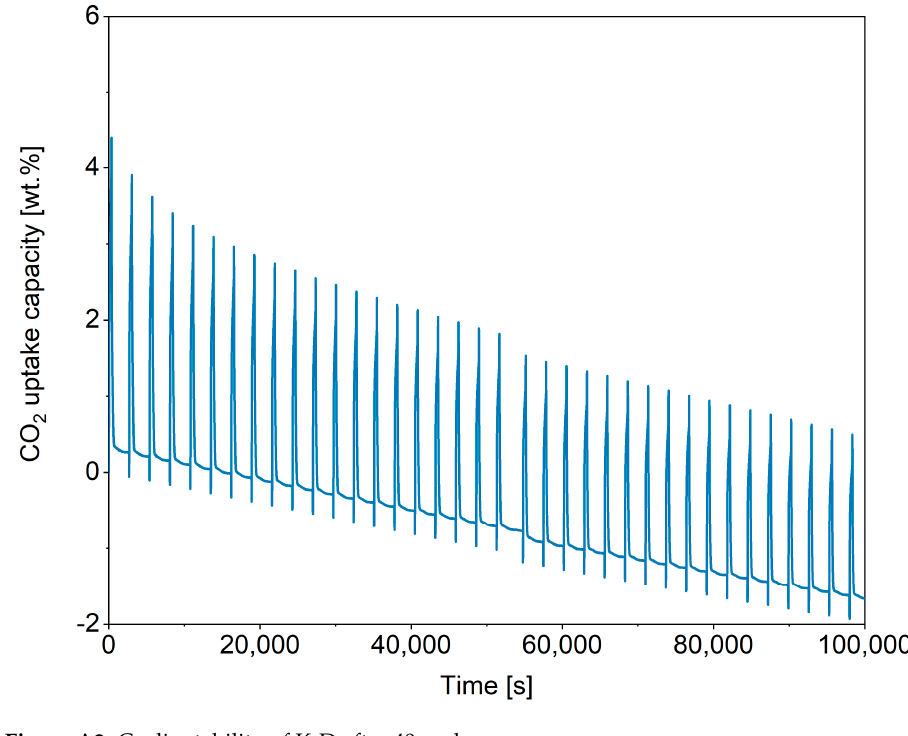
Figure A2. Cyclic stability of K-D after 40 cycles.